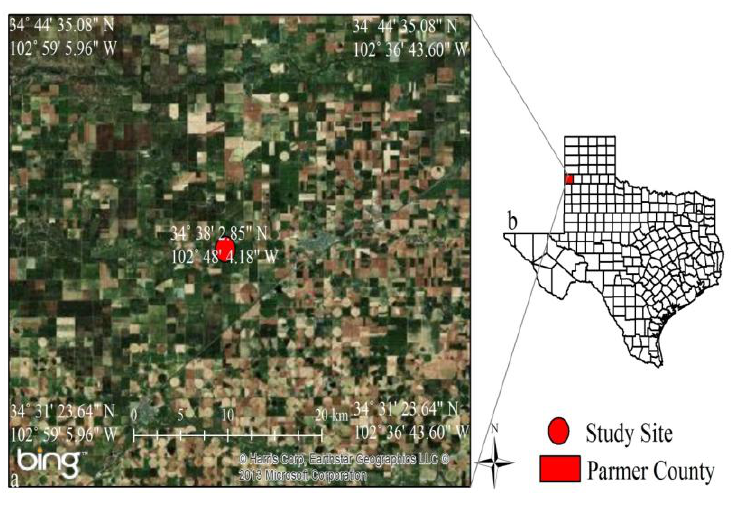
Figure 1. Location of study site in Parmer County ( a ) in TX ( b ),